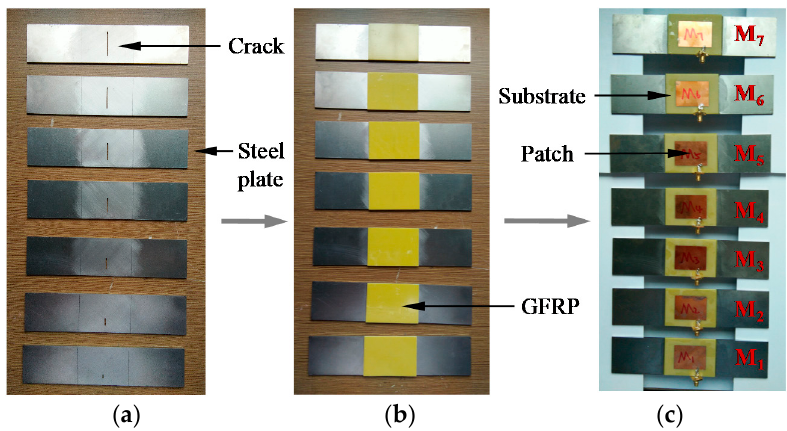
Figure 4. Specimen fabrication process stages: ( a ) steel plates with various crack lengths; ( b ) cracked steel plates when strengthened using glass fiber reinforced polymer (GFRP); ( c ) finished specimens. A vector network analyzer (VNA) is used to measure the resonant frequency of the antenna sensor, and the results are compared with those of the simulations, as shown in Figure 5. Every data point in Figure 5 is an average of three measurements.